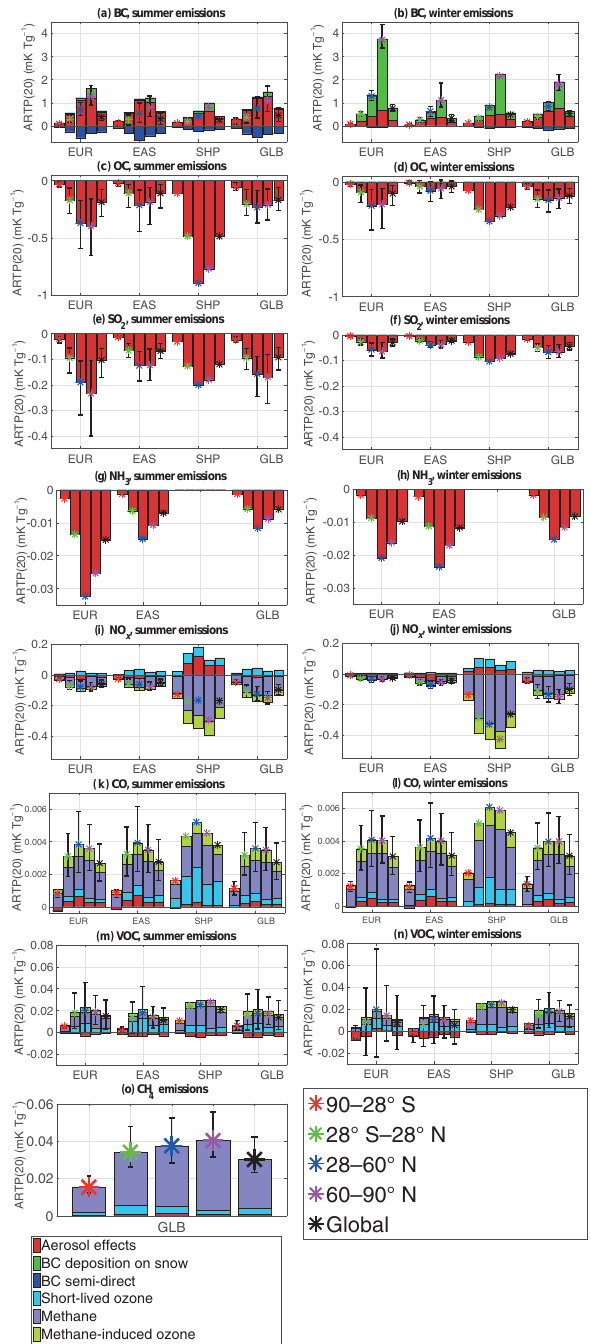
Figure 1. ARTP20 for emissions from Europe, East Asia, shipping, and global emissions for summer and winter. In each frame and for each emission region, the ARTP20 values for the four latitudinal response bands from south (left) to north (right), as well as the global response average (rightmost) for the species, are decomposed by effects. The net response is shown by the asterisk. The regions included are Europe (EUR), East Asia (EAS), shipping (SHP), and the globe (GLB), all for both NH summer, May–October (left), and NH winter, November–April (right). The uncertainty bars show the range across models, which is not given for shipping, as the best estimate is based on only two models for that sector. Due to the methodology applied, a fraction of the semi-direct effect for BC in the Arctic is included in the aerosol effects, as explained in Sect. 2.2.4. Note that the vertical axis varies between different emitted